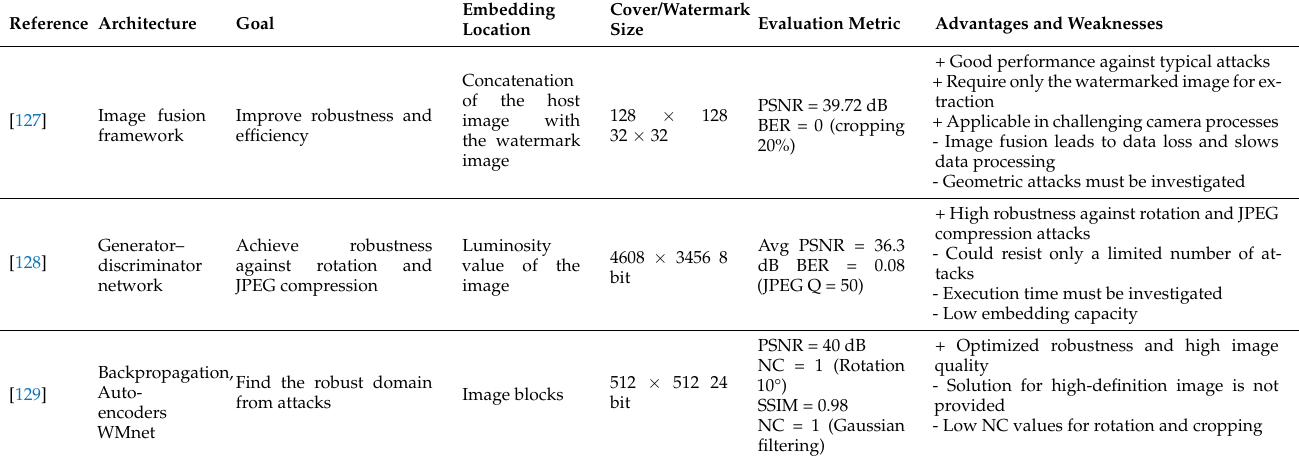
Table 6. Summary of learning-based image watermarking methods for embedding and extraction